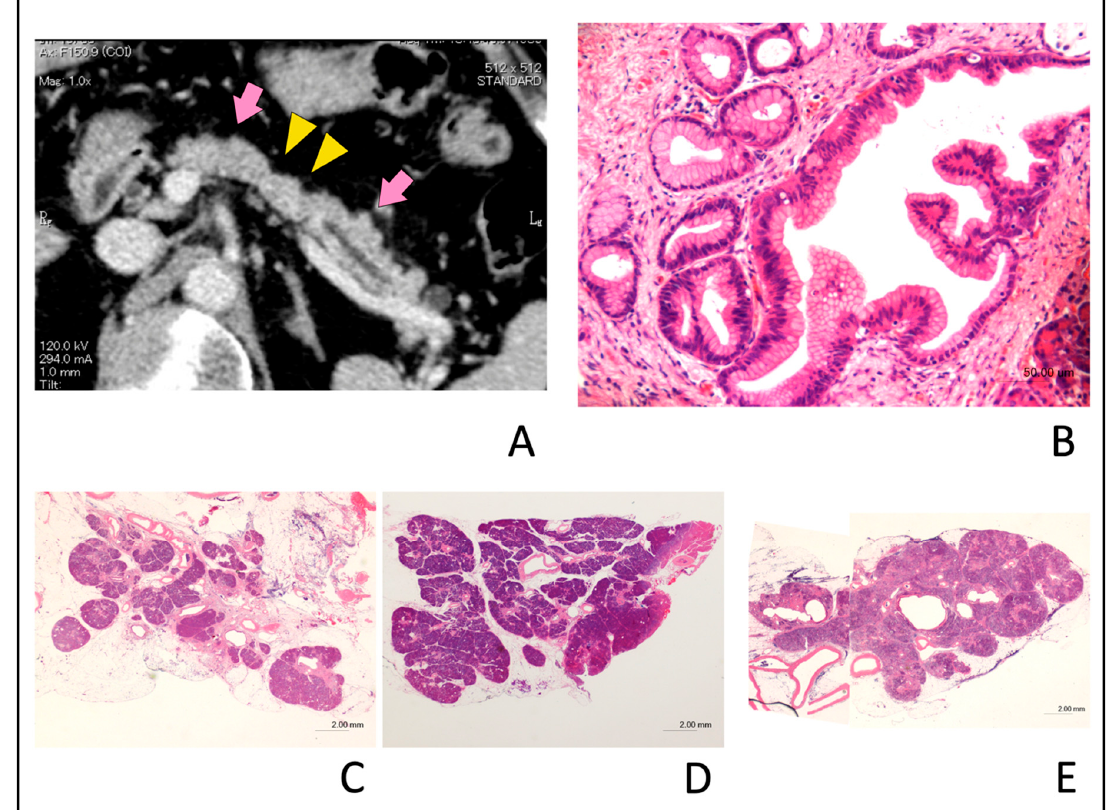
Figure 6. Typical computed tomography (CT) images showing partial pancreatic parenchymal atrophy (PPA) in an 81-year-old man with stage 0 (carcinoma in situ) pancreatic cancer. Localized main pancreatic duct (MPD) stenosis without tumor lesion in the pancreatic body was detected in CT for further examination of a small cyst in the pancreatic tail. ( A ); The area exhibiting PPA had an atrophic change corresponding to the distribution of MPD stenosis (yellow arrow head) and defined as localized atrophy compared with the upstream and downstream parenchyma (pink arrow). ( B ); Hematoxylin and eosin (H&E)-stained resected specimen. Histopathological examination showed high-grade pancreatic intraepithelial neoplasia (PanIN) of the main pancreatic duct (H&E stain, × 20 magnification). ( C ); Severe atrophy and fibrosis of the pancreatic parenchyma and focal fatty change adjacent to the high-grade PanIN (H&E stain, × 0.5 magnification). ( D ); Downstream side of pancreatic parenchyma had no atrophic change as compared with Figure 6C (H&E stain, × 0.5 magnification). ( E ); Upstream side of pancreatic parenchyma had slight fibrosis and focal fatty change as compared with Figure 6C. Acinar cell architecture was maintained (H&E stain, × 1 magnification).